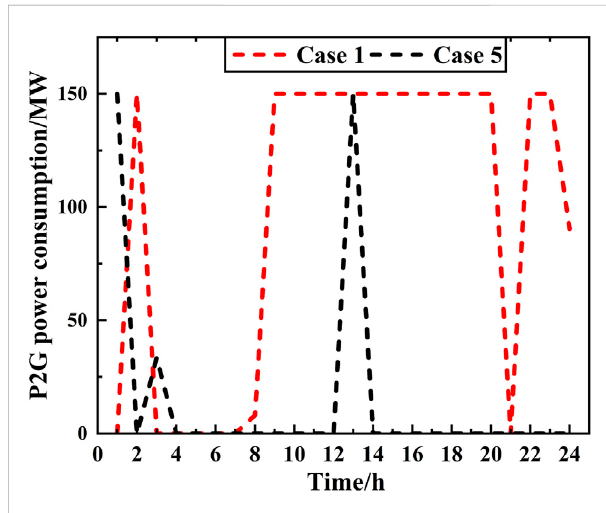
FIGURE 8 P2G power consumption under robust dispatch in Case 1 and Case